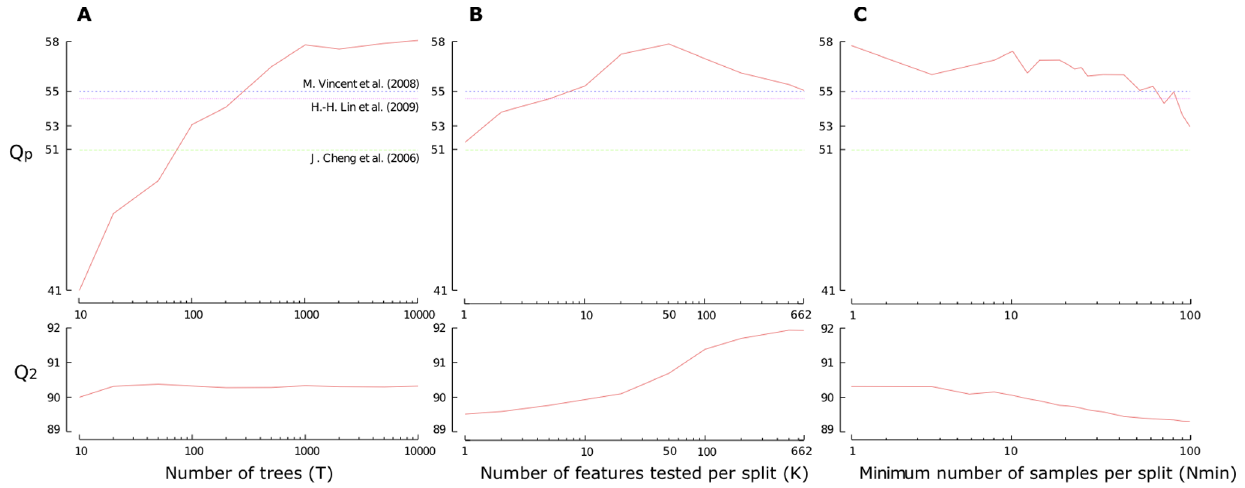
Figure 6. Sensitivity of ETs w.r.t. hyper-parameters. The experiments are performed on the SPX z dataset. We used the two feature functions w ( PSSM ,15) and csp (17) . (A) Impact of the number of trees T (from 10 to 10 000 ) with K ~ ffiffiffi d features. (B) Impact of K (from 1 to d ) with T ~ 1 000 and N min ~ 1 . (C) Impact of N min (from 2 to 101 ).